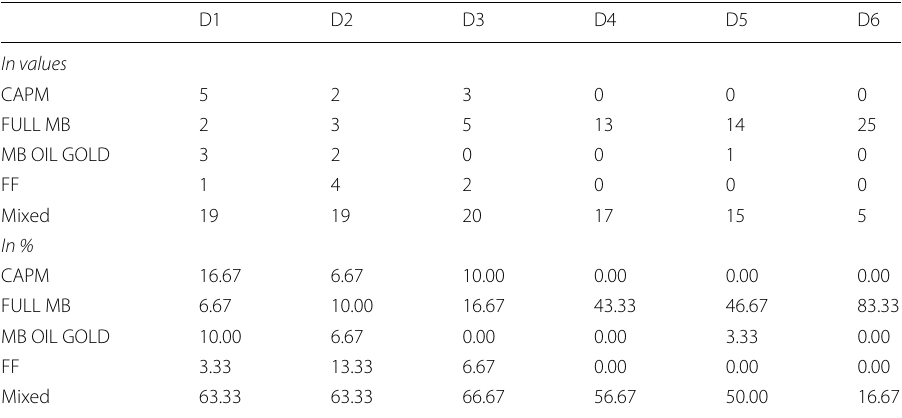
Table 3 Analysis of Time–Frequency Multi-Betas Model results. Number of stocks for which the CAPM or the Multi-Betas is valid (in values and percentage) D1 D2 In